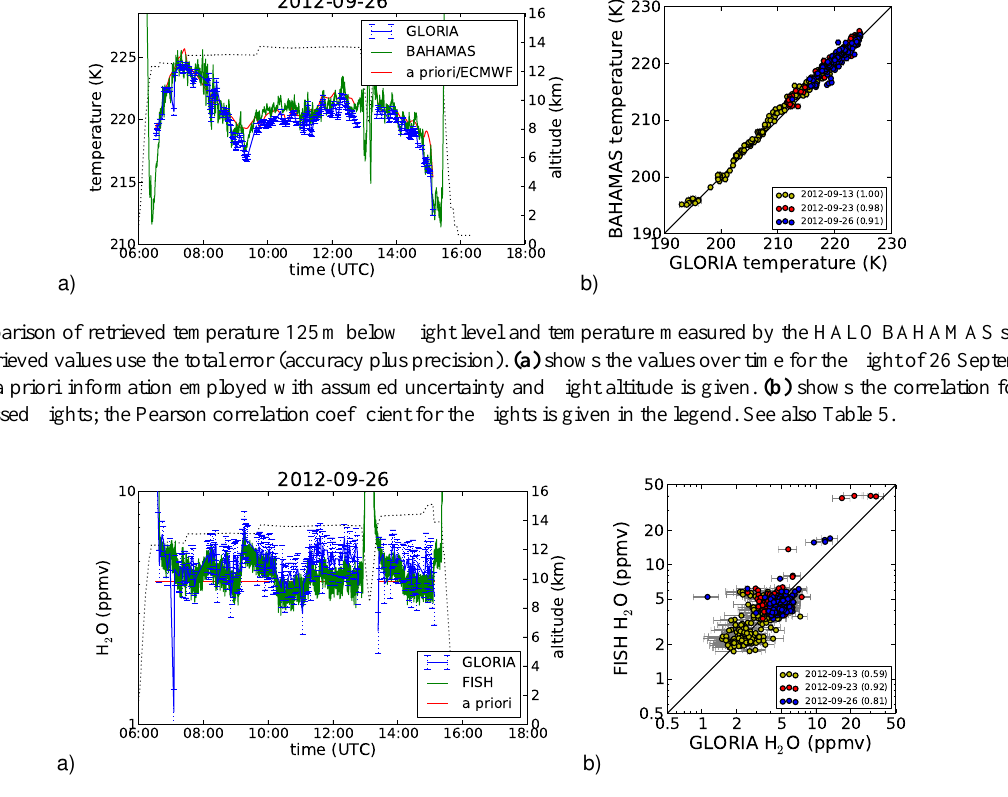
Figure 8. Comparison of retrieved H 2 O 125 m below flight level and H 2 O measured by FISH. See also Fig. 7 and Table 5. Table 5. Comparison of retrieved targets 125m below flight level and quantities measured by in situ instruments (BAHAMAS, Fairo, FISH, and AIMS). Shown are the mean difference and the SD. The last column shows the Pearson correlation coefficient for the linear correlation between retrieved and in situ measured